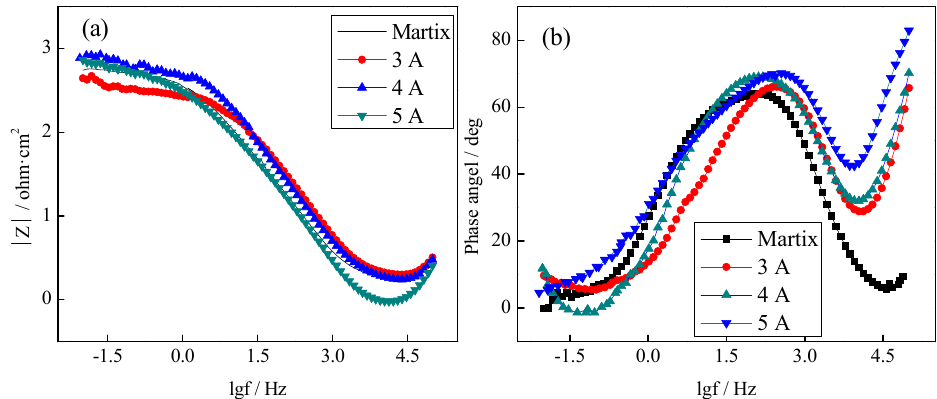
Figure 10. Bode curves of the CrN x coating under di ff erent filament currents (( a ) Impedance mode value ( | Z | ) versus frequency (f) curves, ( b ) Phase angle versus frequency (f) curves). Figure 11 showed the equivalent analog circuit diagram of EIS under di ff erent filament